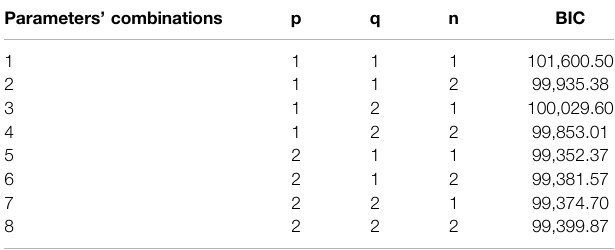
TABLE 2 | BIC trend for different orders of Legendre polynomials. Parameters ’ combinations